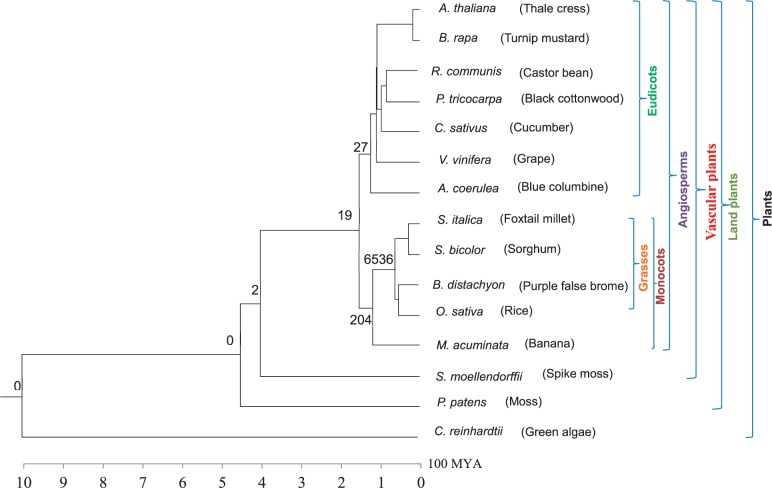
Phylogenetic tree with the number of lineage-specific CNSs. The numbers on each branch represent the number of lineage-specific CNSs found in the study. The main plant groups considered in the study are depicted on the right. The phylogenetic tree was constructed with verified divergence times taken from Anderson et al. (2005), D’Hont et al. (2012), Banks et al. (2011), Heckman et al. (2001), and Rensing et al. (2007).